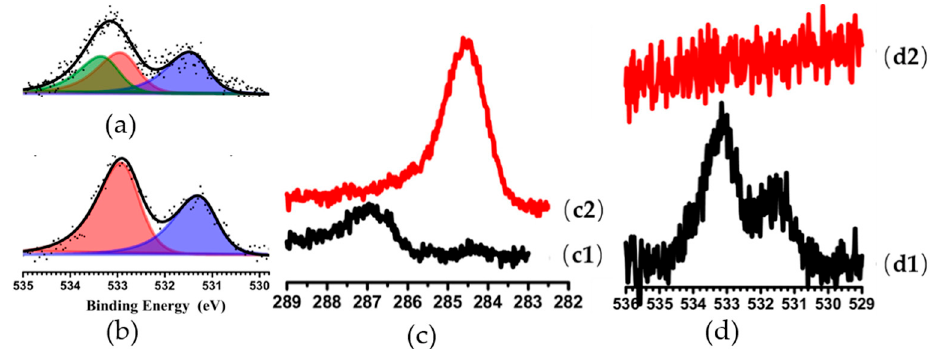
Figure 11. O 1s peaks of CO chemisorbed on pure ( a ) Pt (111) and ( b ) Pt/Cu/Pt (111) in 2 Torr CO at 300 K. C 1s of CO chemisorbed on Pt/Cu/Pt (111) ( c1 ) in 2 Torr CO at 300 K and ( c2 ) in 2 Torr CO at 573 K. O 1s of CO chemisorbed on Pt/Cu/Pt (111) ( d1 ) in 2 Torr CO at 300 K and ( d2 ) in 2 Torr CO at 573